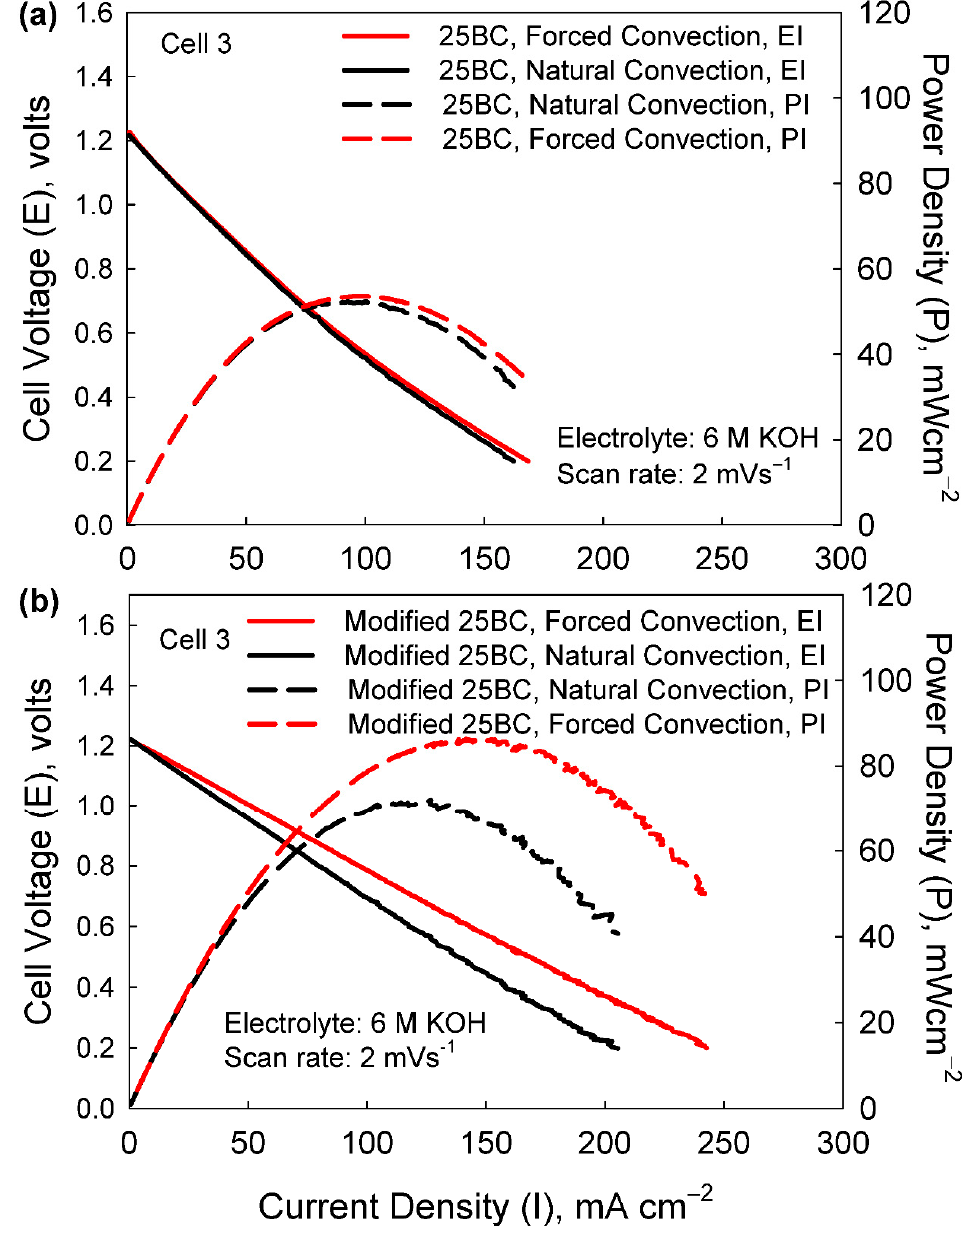
Figure 7. The E–I and P–I curves of Cell 3: ( a ) 25BC as ORR electrode and ( b ) modified 25BC as ORR electrode.